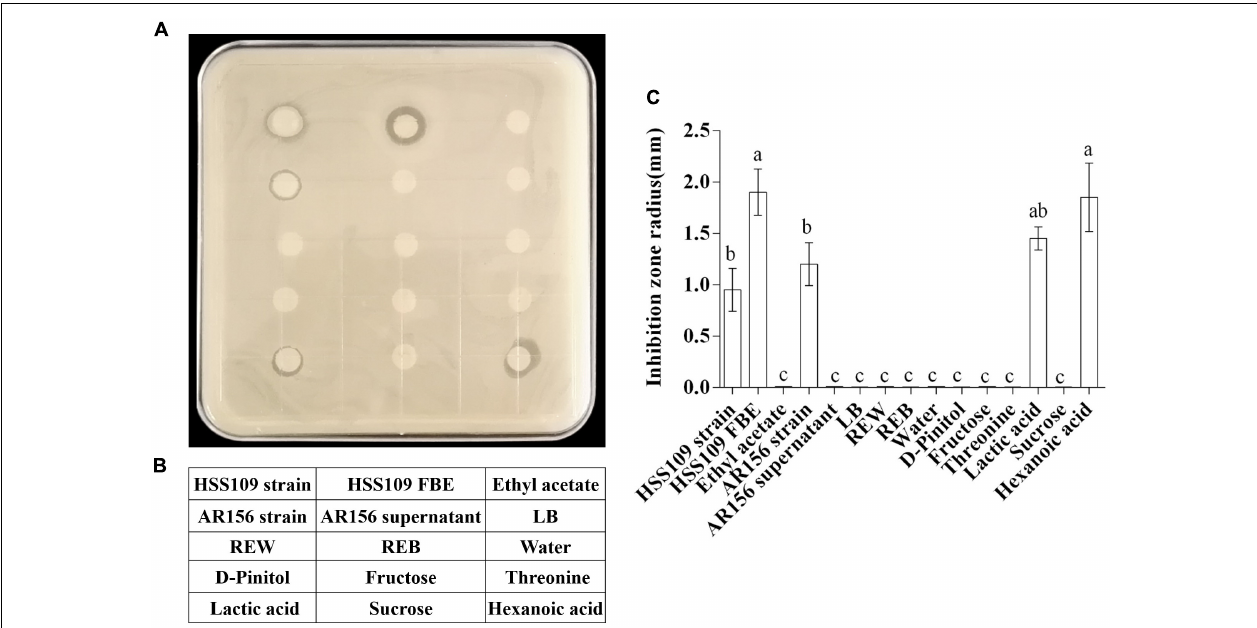
FIGURE 3 | Antagonistic effects of components in tomato root exudates induced by Bacillus cereus AR156 against Ralstonia solanacearum HN4. (A) In vitro antagonism test of components in tomato root exudates induced by B. cereus AR156 against R. solanacearum HN4. Arrangement of tested compositions was described in (B) . Bacillus amyloliquefaciens HSSN09 and Bacillus cereus AR156 strains were tested in 5 × 10 7 CFU/mL, HSSN09 FBE indicates the fermentation broth extract of Bacillus amyloliquefaciens HSSN09 in 20 mg/mL, tested root exudates was in the concentration of 8.74 mg/mL, other tested components were in the concentration of 100 mM. The results in (A) are quantified in (C) . The mean and standard error values of three biological replicates are reported for each treatment. Different letters within a column indicate significantly different among treatments according to the Duncan’s multiple range tests test ( P < 0.05). The experiment was carried out three times and one representative experiment is reported.